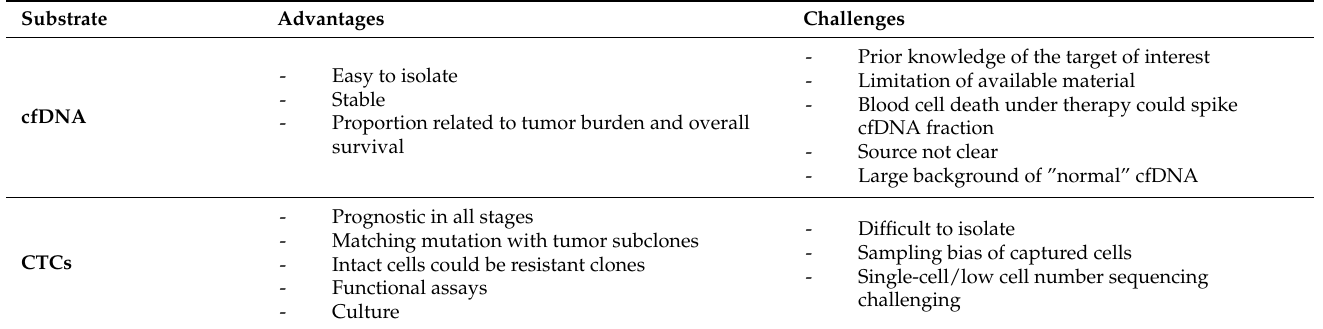
Table 1. Advantages and challenges of single substrates used for liquid